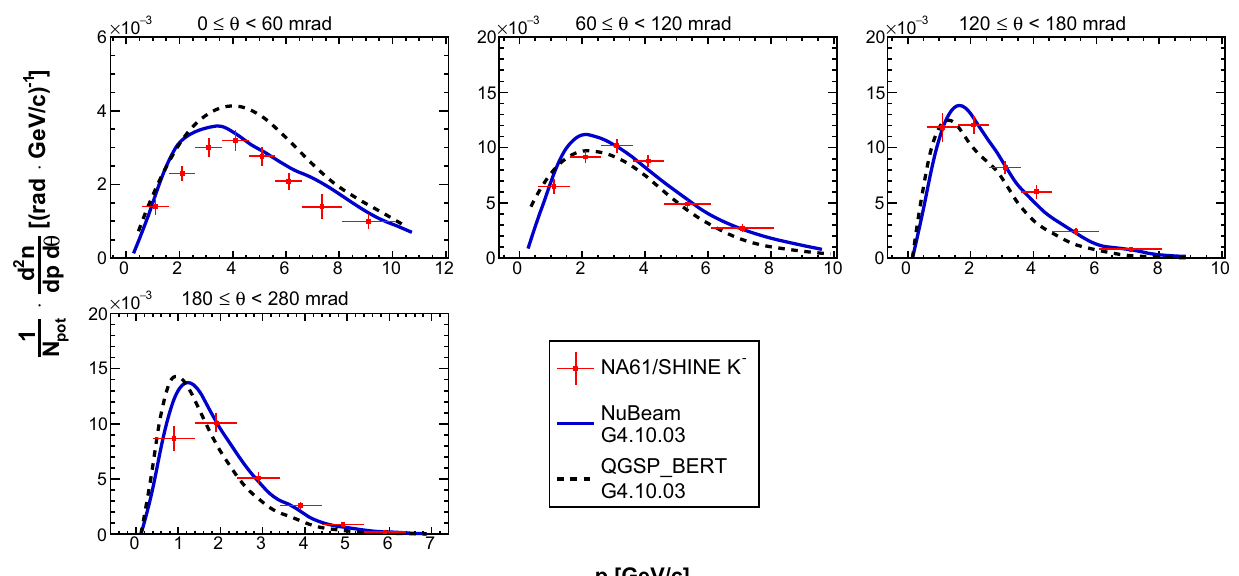
Fig. 43 Double differential yields of negatively charged kaons for the third upstream longitudinal bin (36 ≤ z < 54 cm). Vertical bars represent the total uncertanties. Predictions from the NuBeam (solid